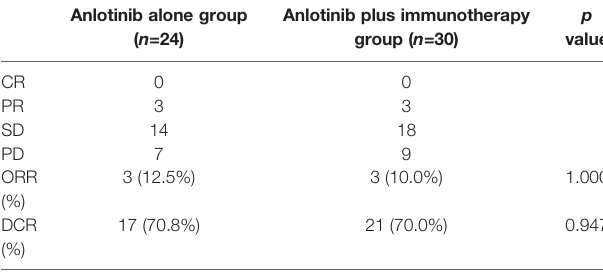
TABLE 4 | Response of anlotinib alone and anlotinib plus immunotherapy. Anlotinib alone group Anlotinib plus immunotherapy ( n =24) group ( n